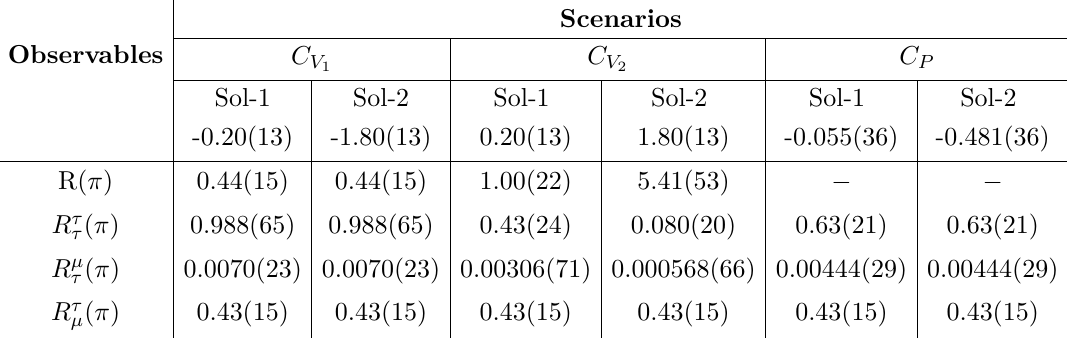
Table 3. The results of the observables defined in eq. (2.9) corresponding to the two NP solutions obtained from fitting the ‘Fit-3’ dataset considering NP effects in B ( B → τν ) . Sol-1 corresponds to the solution close to the SM. Sol-2 corresponds to the solution away from the SM.